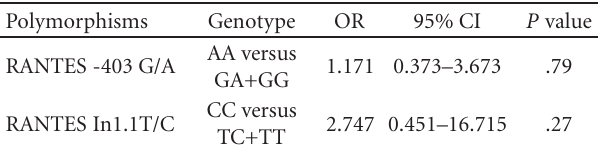
Table 4: Multivariate logistic regression analysis of the MI risk according to RANTES genotypes in the Slavonic population adjusted for age and